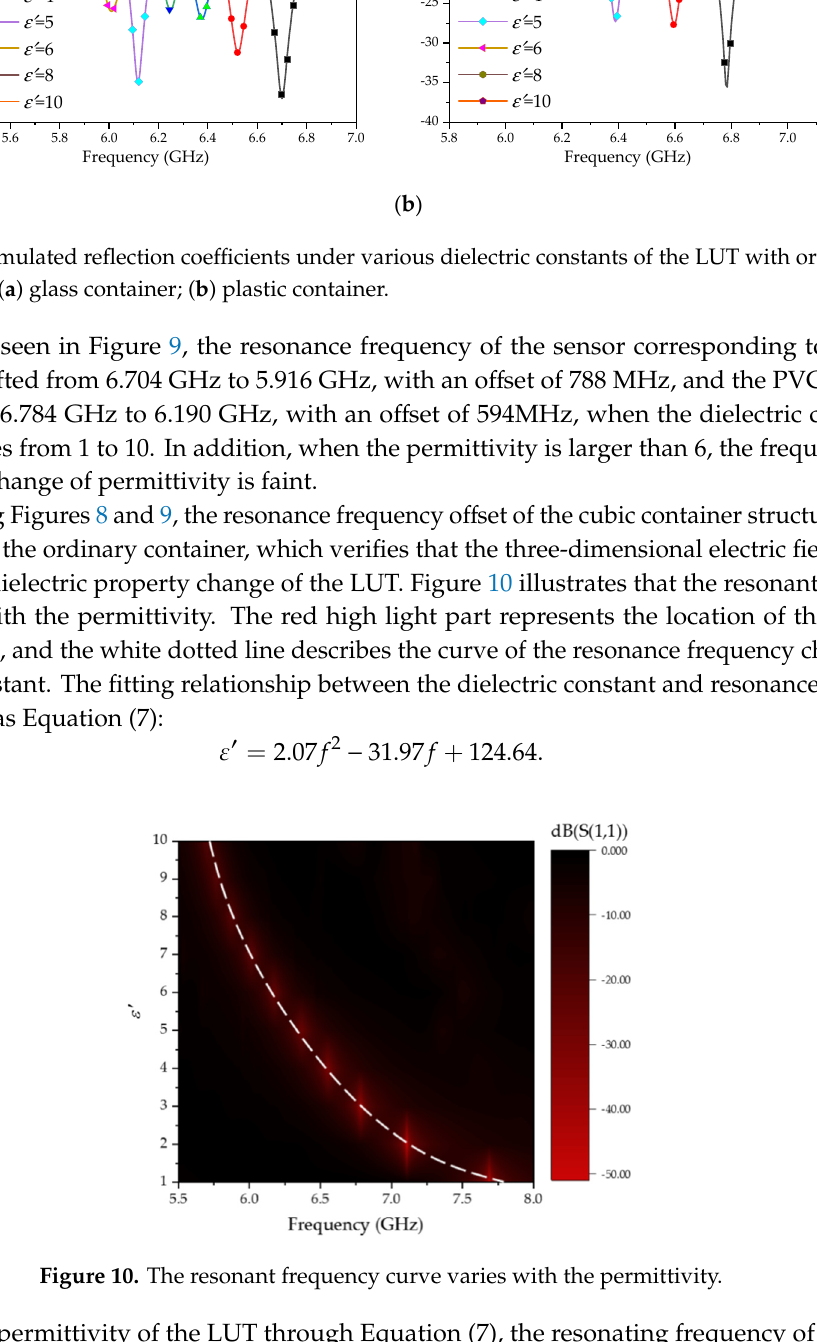
Figure 10. The resonant frequency curve varies with the permittivity.